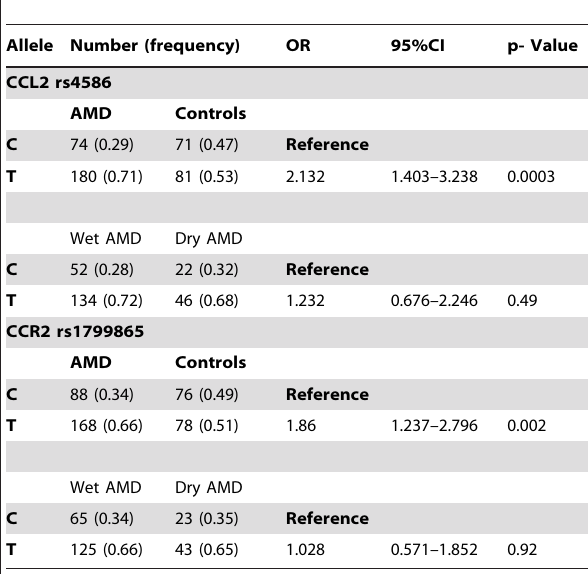
This table summarizes the allele frequencies for the single-nucleotide polymorphisms (SNPs) in CCL2 rs4586 and CCR2 rs1799865 among patients with age-related macular degeneration (AMD) and control subjects. The p-value represents comparison of risk significance between AMD cases and controls. OR indicates odds ratio and CI refers to confidence interval.